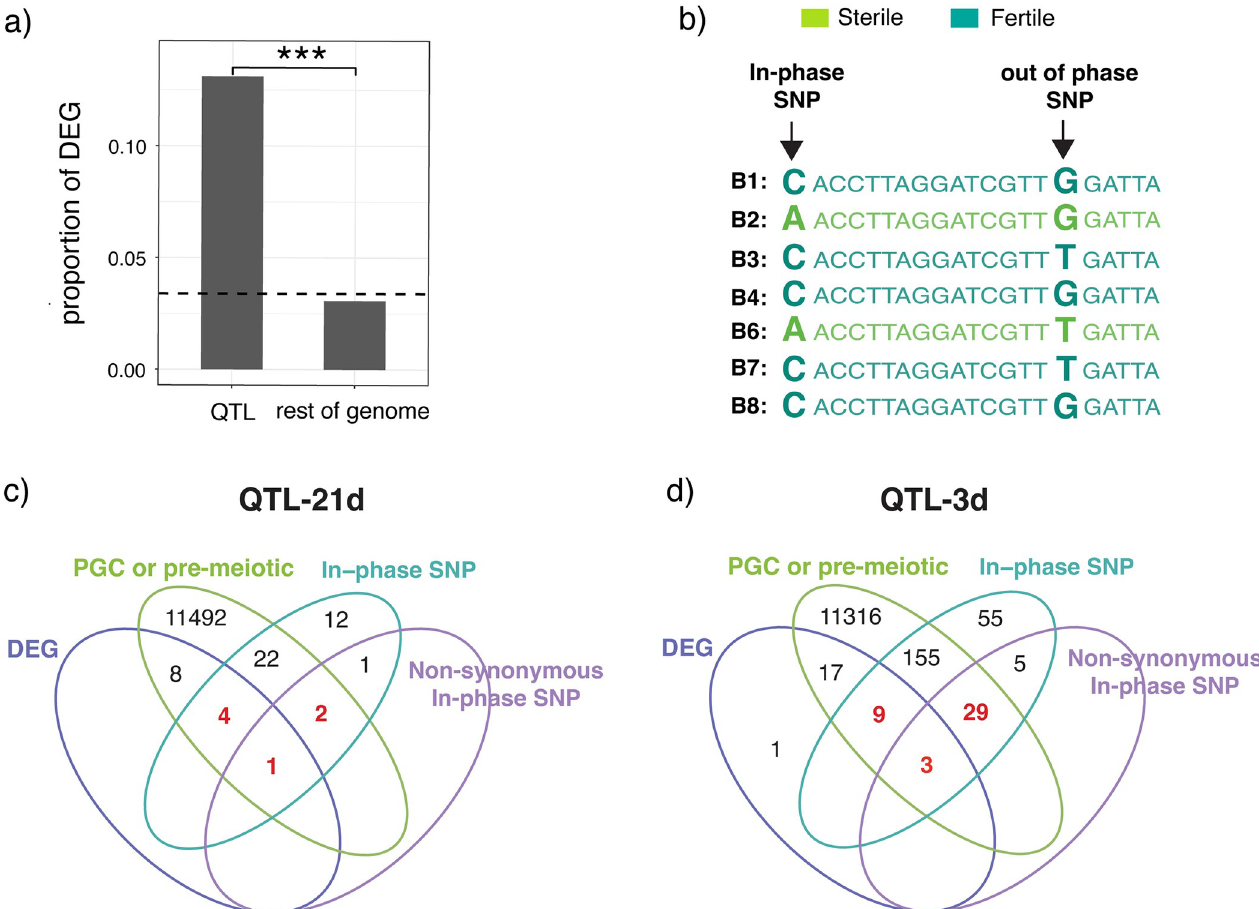
Fig 6. Differential expression and in-phase SNPs identify candidate genes. a) The proportion of genes differentially expressed (DEG) is compared inside and outside the QTL. The dotted line is the genome wide average. b) Hypothetical in-phase and out of phase SNPs are shown. Sequences of each of the B founder strains are colored based on their phenotypic classification, either fertile or sterile ( Fig 1E ). Bold letters indicate SNPs. c and d) Venn diagrams showing the overlap of differentially expressed genes (DEG), genes carrying in-phase synonymous and non-synonymous SNPs, and genes expressed in primordial or pre- meiotic germ cells for QTL-21d (c) and QTL-3d (d).The data for differential expression of genes for fertile and sterile genotypes is provided in S5 Table . The data on in-phase polymorphisms for each QTL peak are provided in S11 Table . List of candidate genes that have both in-phase polymorphisms and are differentially expressed, and those having non-synonymous in-phase polymorphisms are provided in S12 and S13 Tables ,